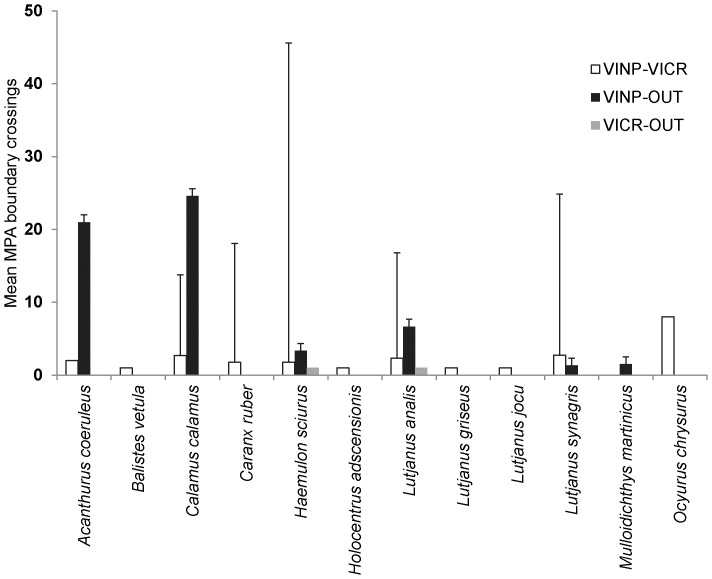
Mean (± SE) number of times individuals of a fish species crossed a management boundary (VINP – Virgin Islands National Park; VICR – Virgin Islands Coral Reef National Monument; Out – outside MPA) in the U.S.Virgin Islands (based on receiver detections) during the study period. Individuals from 12 of 18 species were confirmed to have crossed a management boundary.